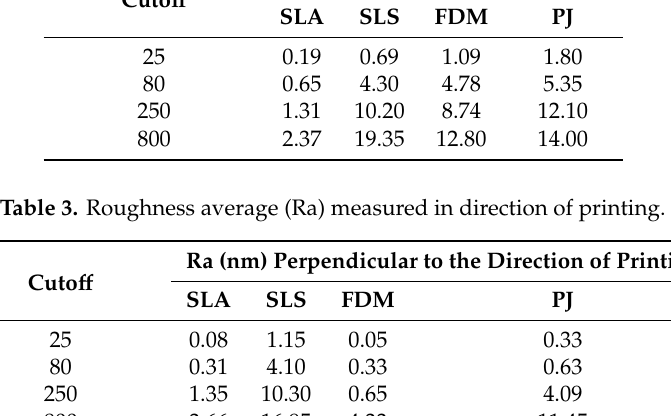
Table 2. Roughness average (Ra) measured in direction of printing. Cuto ff